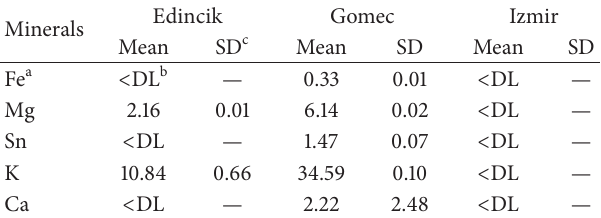
Table 7: Mineral contents of virgin olive oils by ICP-OES ( 𝜇 g/g).